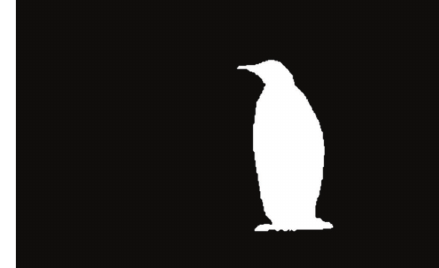
Figure 3: Salient region